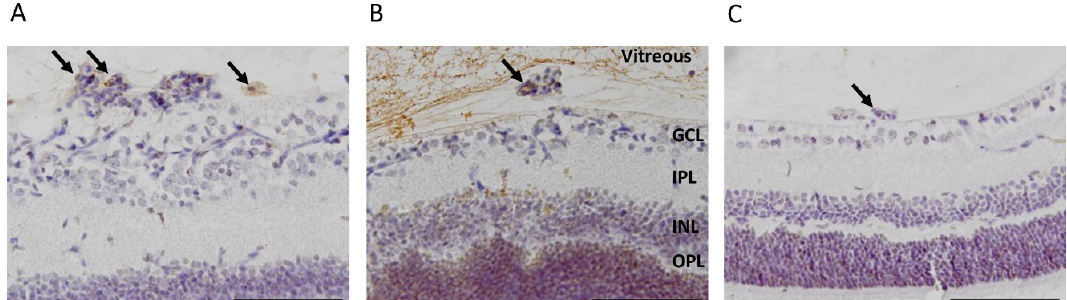
Figure 4. CAR-peptide homes to the preretinal tufts of R-Ras KO animals and accumulates in the vitreous. CAR-peptide (in brown) was seen in the preretinal tufts ( A ) and strong accumulatio was seen in the vitreous of R-Ras KO animals ( B ). Less CAR-peptide was seen in the vitreous of WT animals ( C ). ( N = 2 for KO and 6 for WT). Scale bars represent 100 µm. The arrows are pointing to the CAR peptide in the preretinal tufts, i.e. pathological neovessels.